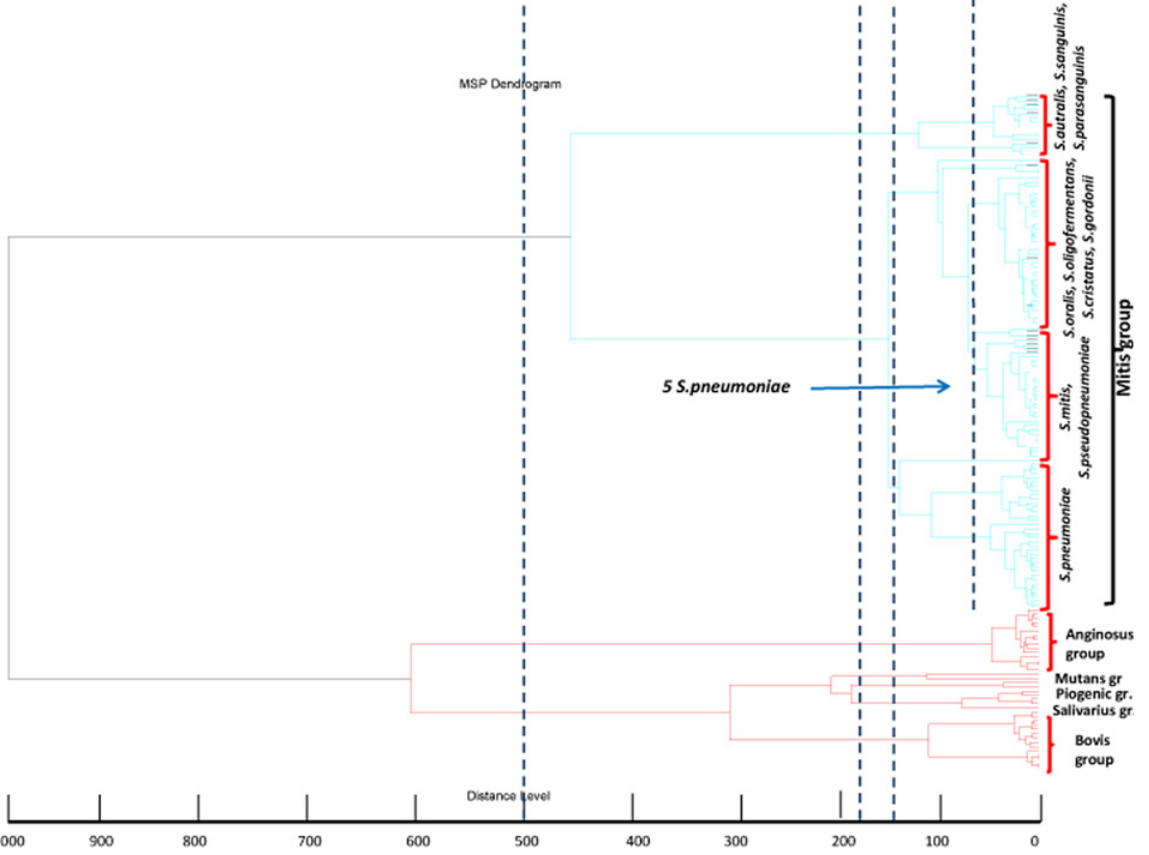
Fig 1. MSP classification dendrogram. Dotted lines position indicates the arbitrary distance levels at 500, 180, 140 and 70 used for strains clustering analysis.